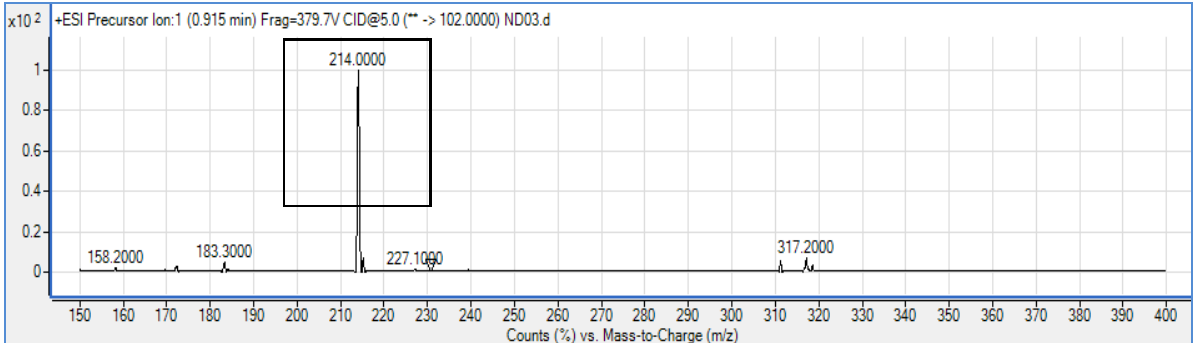
Figure 4. Mass spectrum of AHLs extracted from the spent supernatant of Pantoea rodasii strain ND03 by Triple Quadrupole LC/MS. Strain ND03 produced 3-oxo-C6-HSL ( m/z 214.0000)